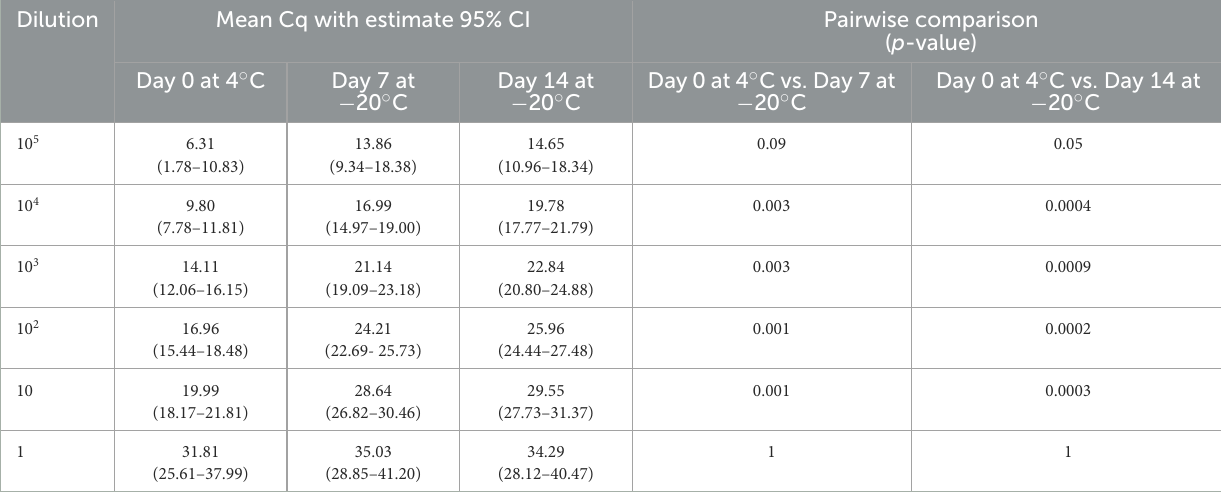
TABLE 5 Tritrichomonas foetus direct RT-qPCR is shown as mean quantitation cycle (Cq) values and an estimated 95% confidence interval (in parentheses).